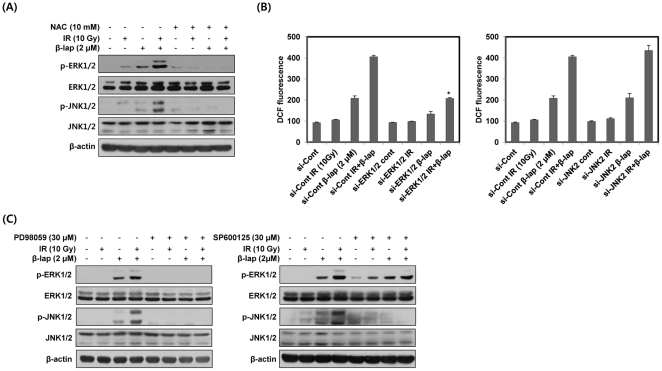
β-lap in combination with IR induces positive feedback regulation between ERK and ROS.(A) NQO1+-MDA-MB-231 cells were treated with IR alone, β-lap alone or combination of IR and β-lap for 30 min in the presence or absence of NAC. The data represent a typical experiment conducted three times with similar results. (B) NQO1+-MDA-MB-231 cells were treated with IR alone, β-lap alone or combination of IR and β-lap for 3 h in the presence or absence of siRNA targeting ERK1/2 or JNK2. After 3 h, the cells were incubated with 10 µM H2DCF-DA for 30 min and then analyzed by flow cytometry. Results from three independent experiments are expressed as means ± SEMs. (C) NQO1+-MDA-MB-231 cells were treated with IR alone, β-lap alone or combination of IR and β-lap for 30 min in the presence or absence of PD98059 or SP600125. The data represent a typical experiment conducted three times with similar results.